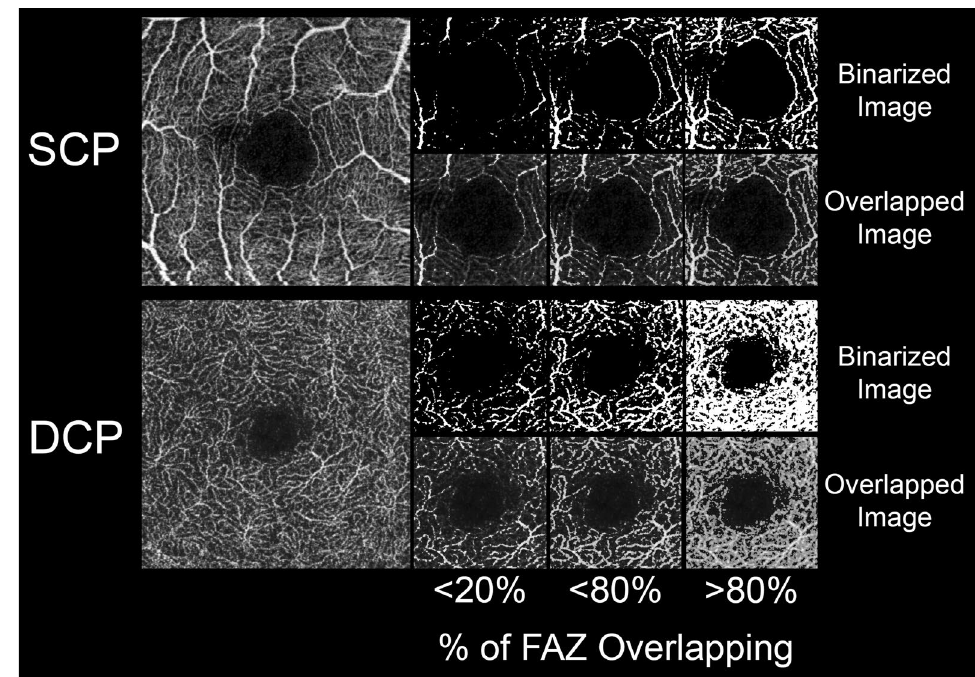
Figure 6. Examples of FAZ overlapping. The three FAZ scores (< 20% of overlapping, < 80% of overlapping and > 80% of overlapping) are respectively